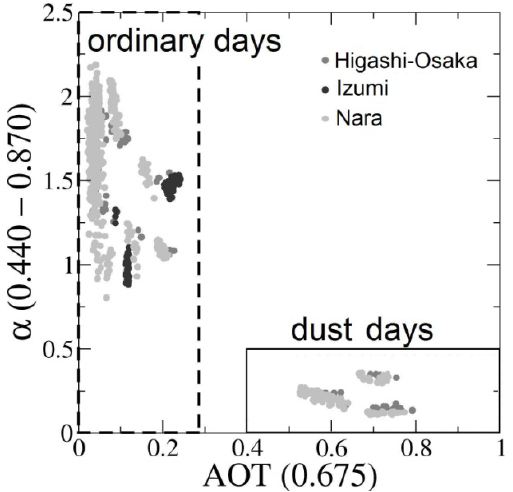
Figure 6. Scatter diagram of (0.440–0.870 m) against the AOT (0.675 m) at Higashi-Osaka, Izumi and Nara from April to November 2011.